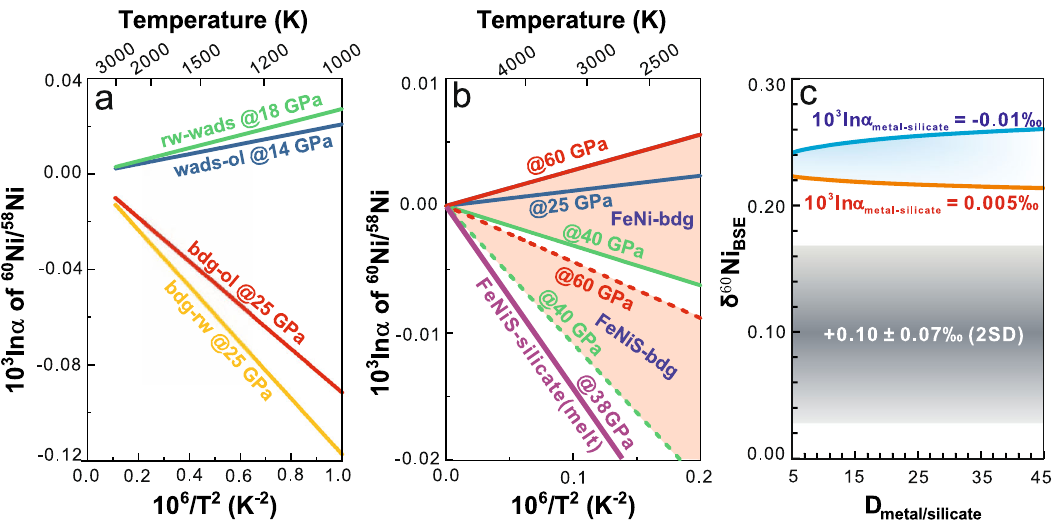
Fig. 3 Equilibrium fractionation factors from fi rst-principles calculations and the modeled Ni isotope fractionation during core – mantle differentiation. a Equilibrium fractionation factors (10 3 ln α ) between olivine, wadsleyite, ringwoodite, and bridgmanite. b Equilibrium fractionation factors between Fe – Ni (S) alloy and bridgmanite, and between FeNiS melt (Fe 92 Ni 5 S 3 ) and silicate melt (Mg 30 NiSi 32 O 96 ). c δ 60 Ni BSE vs. distribution coef fi cient of Ni between metal and silicate ( D Ni metal – silicate ). If the bulk Earth (BE) has a chondritic Ni isotopic composition, the BSE δ 60 Ni after core formation can be evaluated